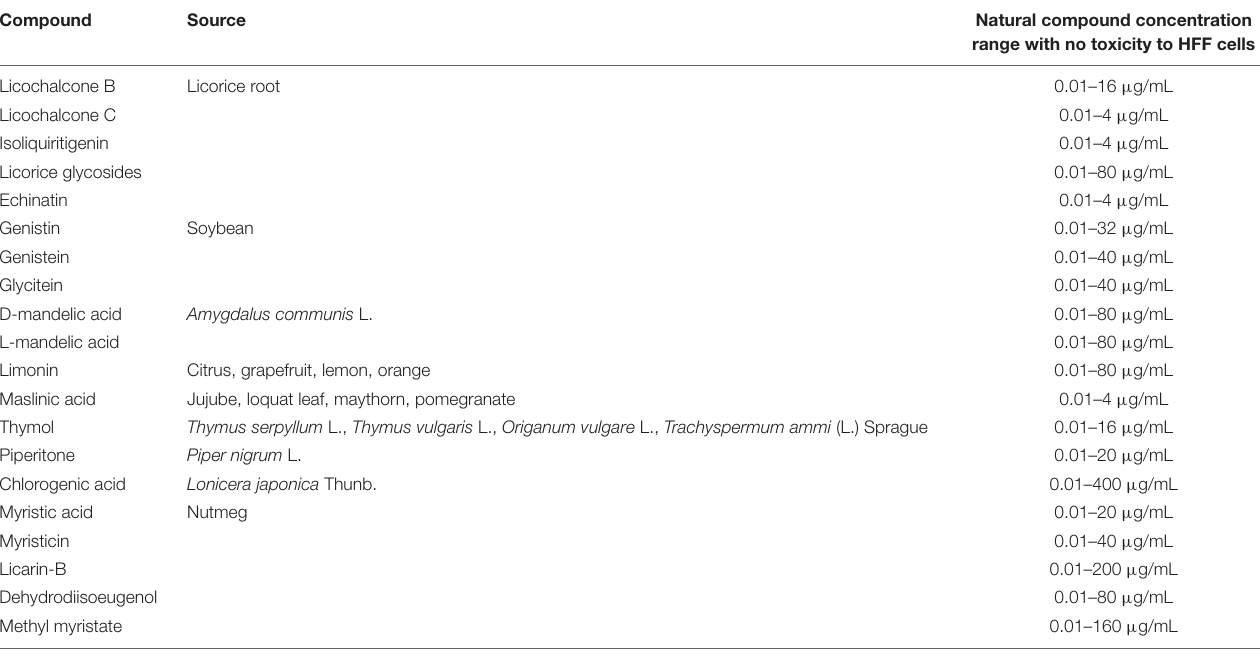
TABLE 1 | Ranges of natural compound concentrations that were not toxic to HFF cells.